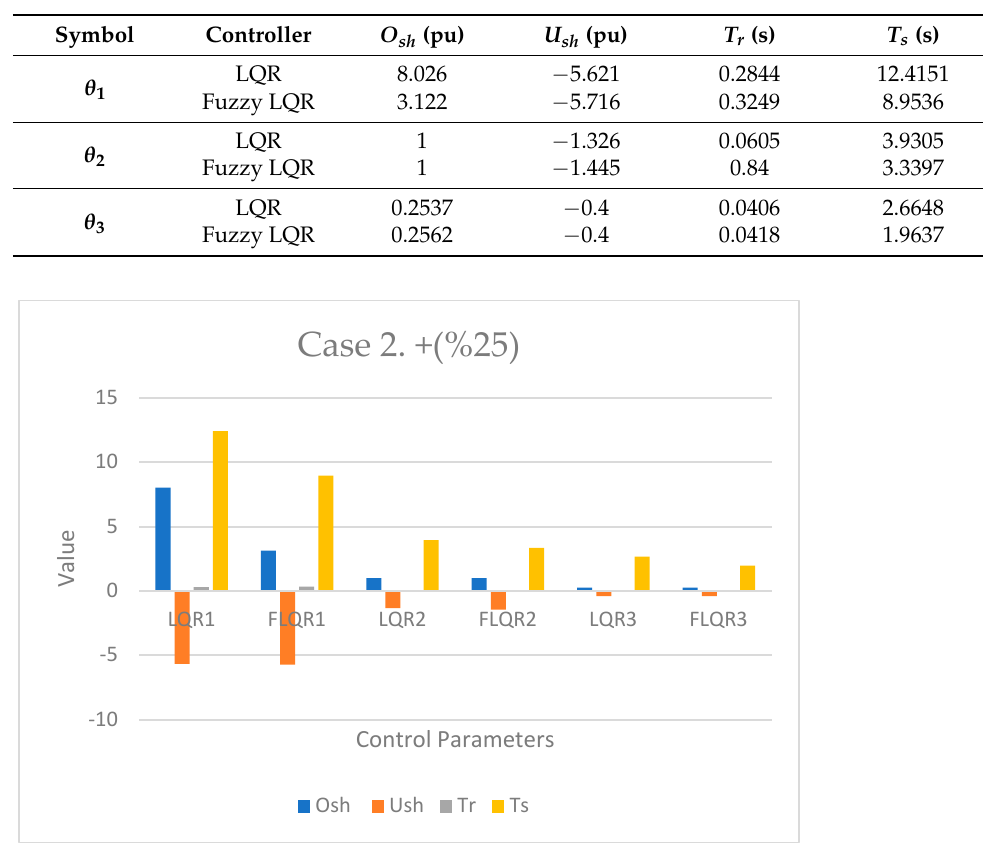
Figure 10. Case 2 comparison.